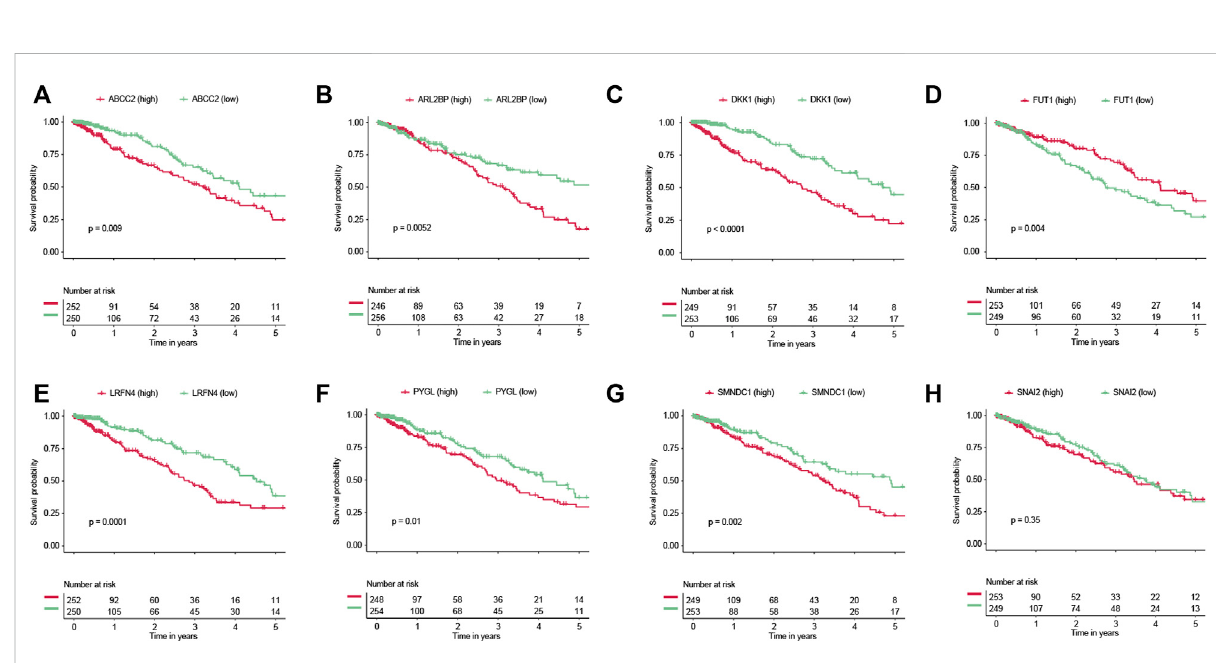
FIGURE 8 Survival analyses of genes. Prognostic values of (A) ABCC2, (B) ARL2BP, (C) DKK1, (D) FUT1, (E) LRFN4, (F) PYGL, (G) SMNDC1, and (H) SNAI2.